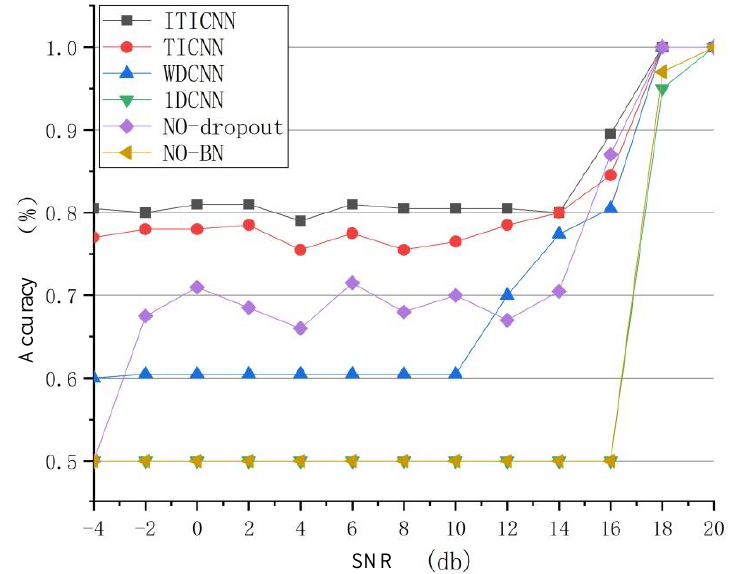
Figure 9. Comparison results of anti-noise ability.